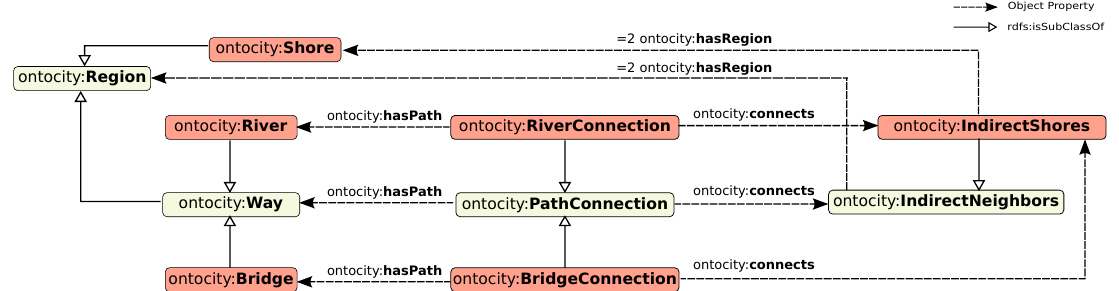
Figure 4. Extension of the PathConnection in OntoCity - River and Bridge